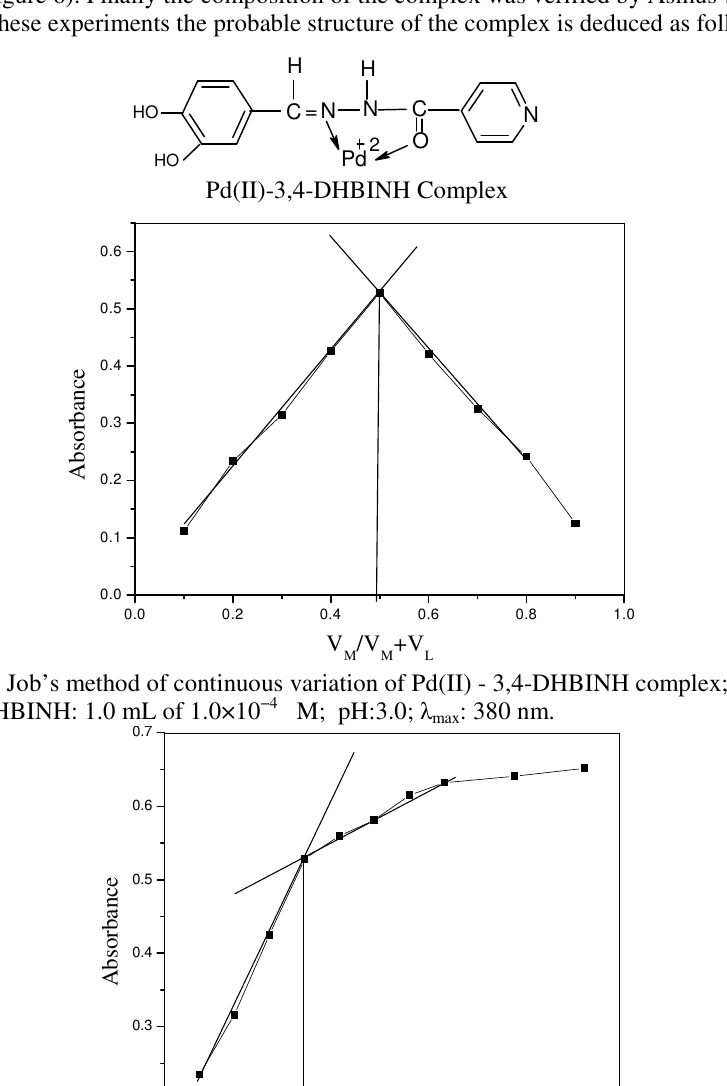
Figure 6. Mole- ratio method of Pd(II) - 3,4-DHBINH complex; Pd(II) and 3,4- DHBINH: 1.0 mL of 1.0×10 −4 M; pH:3.0; λ : 380 max